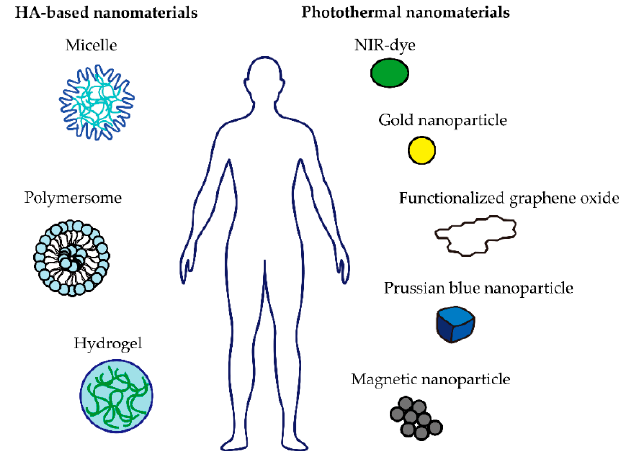
Figure 2. Schemes of hyaluronic acid (HA)-based and photothermal nanomaterials for hyperthermic cancer treatment.